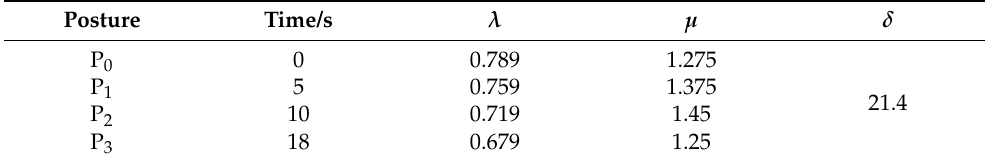
Table 2. The compensation parameters for different postures.